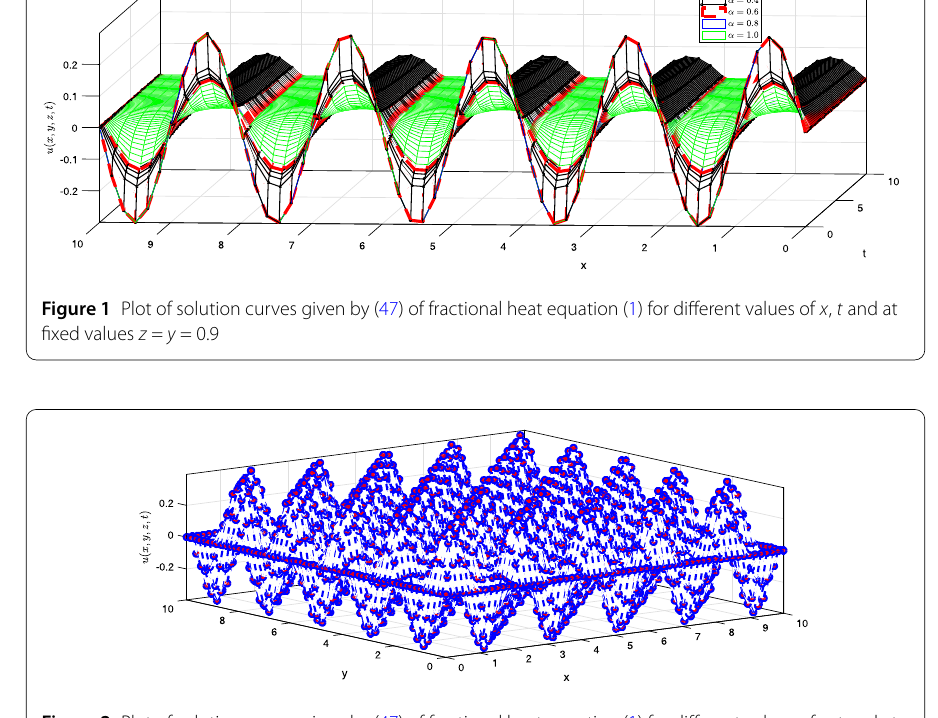
Figure 2 Plot of solution curves given by (47) of fractional heat equation (1) for different values of x , t and at fixed values z = y = 0.9 and α =